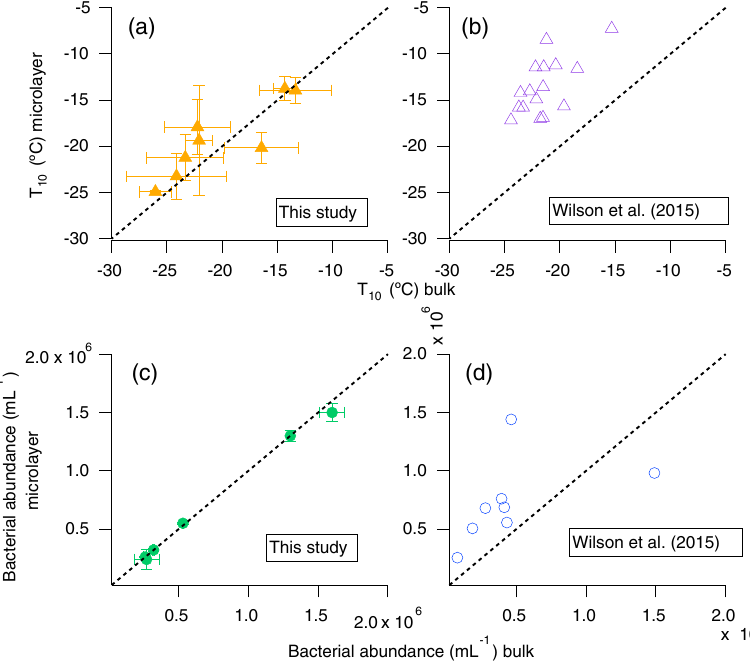
Figure 5. Correlation plots with a 1 : 1 line for reference. Panel (a) shows freezing temperatures for microlayer and bulk seawater samples in this study. T 10 represents the freezing temperatures at which 10% of the droplets had frozen. All error bars represent the 95% confidence intervals of the T 10 values from three replicate experiments. All data have been corrected for freezing point depression. Panel (b) shows T 10 values for microlayer and bulk seawater samples from Wilson et al. (2015). All data have been corrected for freezing point depression. The reported T 10 values for their bulk samples should be considered upper limits since their bulk freezing data were at the detection limit of their instrument. Panel (c) shows bacterial abundance in the microlayer and bacterial abundance in the bulk seawater in this study. There was only one reliable microlayer sample from station 7 for bacterial abundance; therefore, the percentage error for this station was assigned the maximum percentage error from the other bacterial abundance. Panel (d) shows bacterial abundance in the microlayer and bacterial abundance in the bulk seawater from Wilson et al.